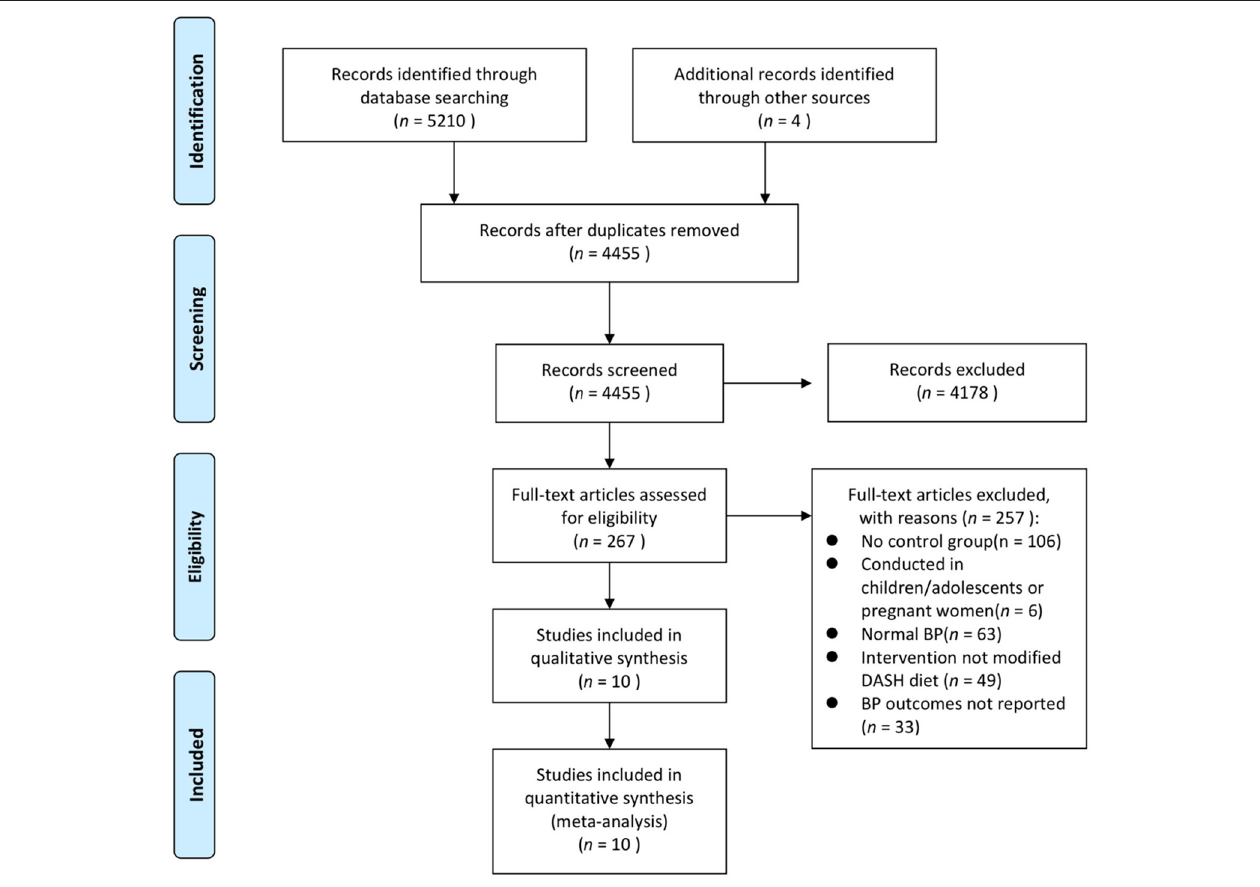
FIGURE 1 | PRISMA flowchart of the included studies. BP, blood pressure; DASH, Dietary Approaches to Stop Hypertension; RCT, randomized controlled trial.